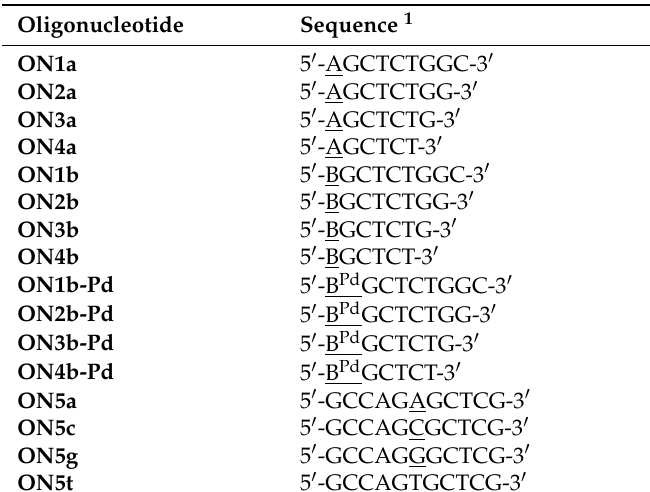
Table 1. Oligonucleotides used in this study.